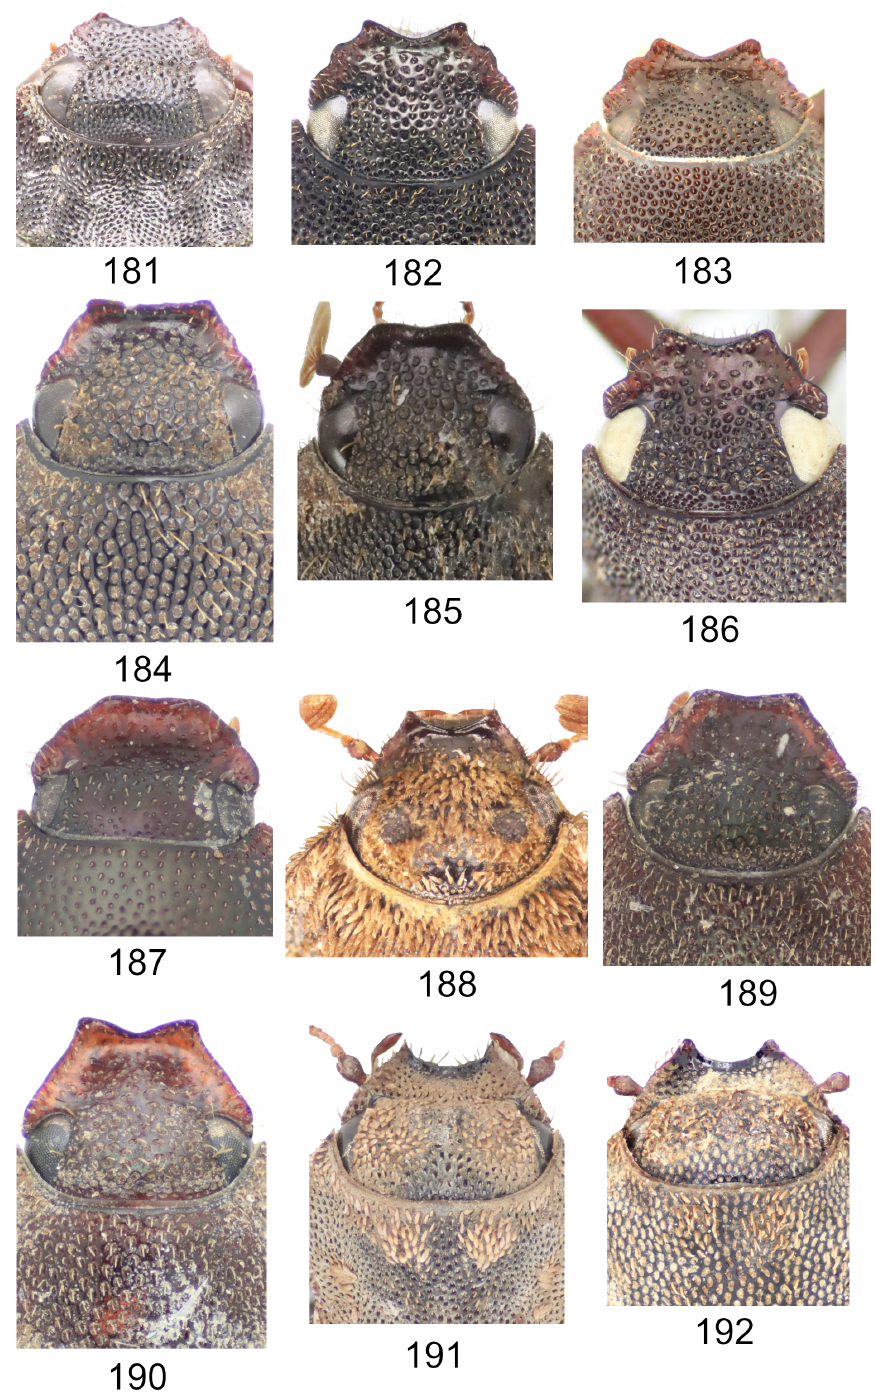
Figs 181–192. Papuan and Wallacean Maechidius Macleay, 1819, head, dorsal view. 181 . M. sturnus Arrow, 1941, holotype, ♂ (BMNH). 182 . M. subcostatus Heller, 1895, lectotype, ♂ (SNSD). 183 . Same, ♀ (SNSD). 184 . M. suwawa sp. nov., holotype, ♂ (BMNH). 185 . Same, paratype, ♀ (BMNH). 186 . M. tarsalis Arrow, 1941, lectotype, ♂ (BMNH). 187 . M. trivialis sp. nov., holotype, ♂ (BMNH). 188 . M. ursus sp. nov., holotype, ♀ (NME). 189 . M. vicinus Heller, 1914, lectotype, ♀ (SNSD). 190 . Same, ♂ (SNSD). 191 . M. weigeli sp. nov., holotype, ♂ (NME). 192 . Same, paratype, ♀ (NME). Not to